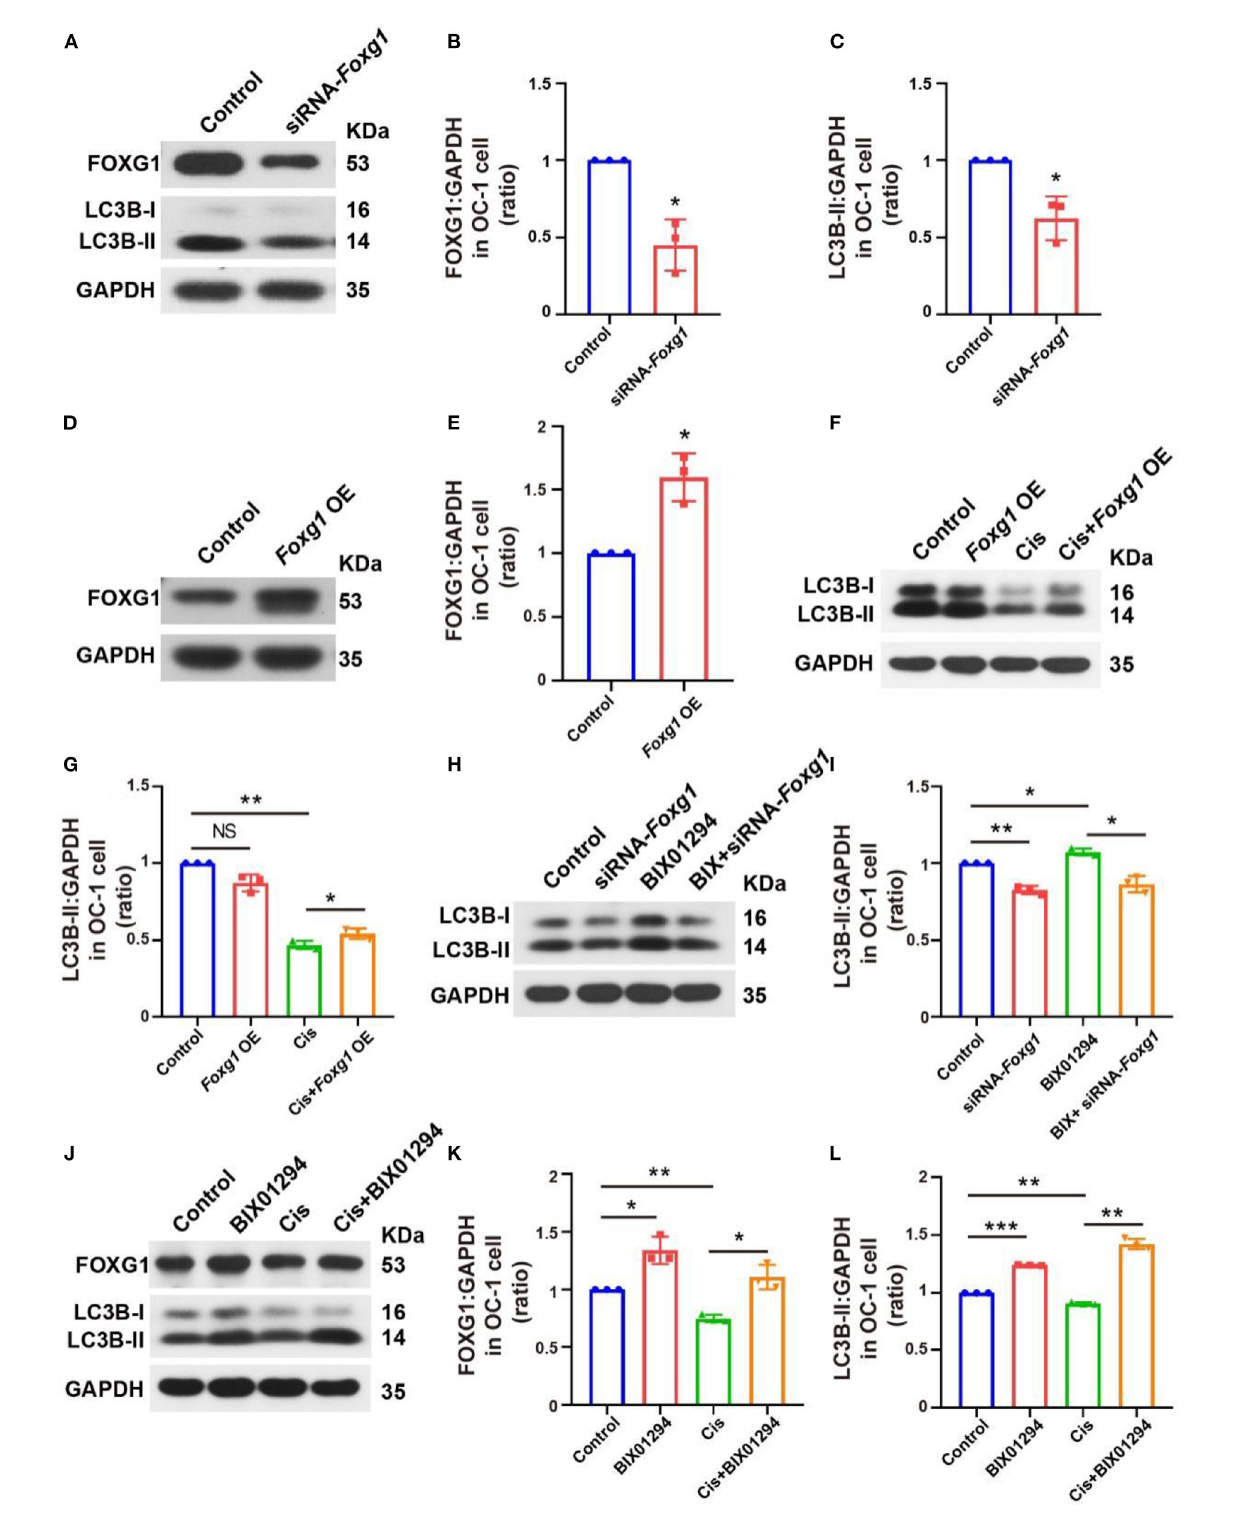
FIGURE6 FOXG1 and BIX01294 may regulate autophagy pathway activation, and the BIX01294-induced autophagy activation pathway may be FoxG1-dependent. (A) Western blotting of FOXG1 and LC3B levels after Foxg1 knock down. (B, C) Quantification of the western blotting in (A) . (D) Western blotting of the Foxg1 overexpression plasmid’s transfection efficiency. (E) Quantification of the western blotting in (D) . (F) Western blotting LC3B levels with Foxg1 overexpression and cisplatin treatment. (G) Quantification of the western blotting in (F) . (H) Western blotting of LC3B levels with Foxg1 knockdown and BIX01294 treatment. (I) Quantification of the western blotting in (H) . (J) Western blotting of FOXG1 and LC3B levels after cisplatin and BIX01294 treatment. (K, L) Quantification of the western blotting in (J) . * p < 0.05, ** p < 0.01, *** p <